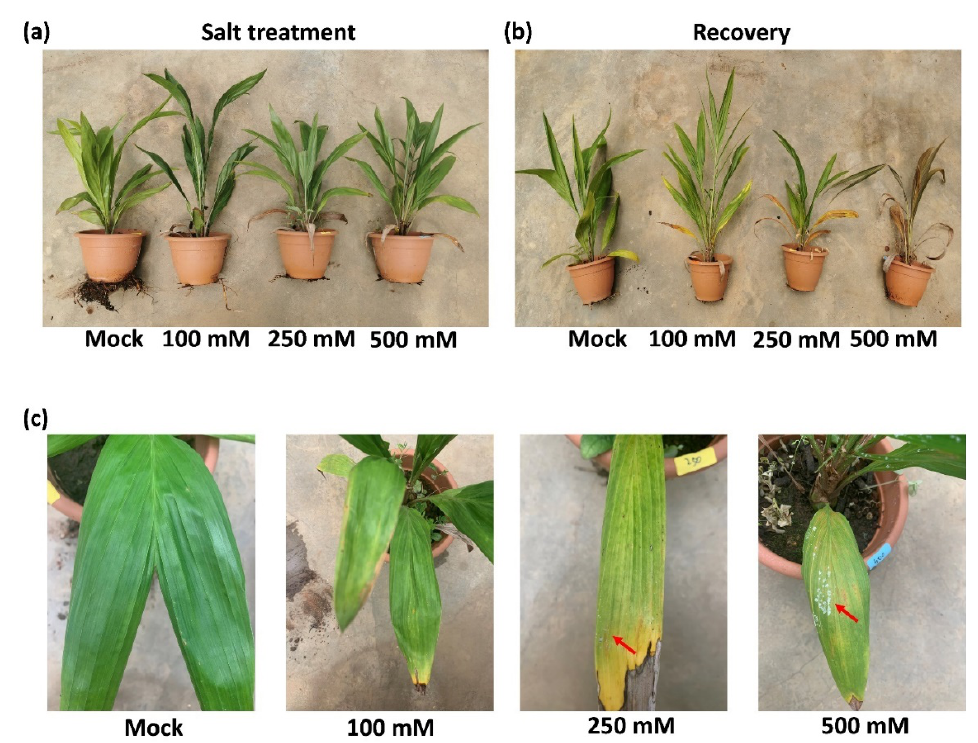
Figure 1. Phenotypical changes of oil palm seedlings in response to different levels of salt stress. ( a ) Circa 2-year-old oil palm seedlings were treated daily with either 150 mL water (Mock) or 150 mL NaCl with four gradient concentration: 100 mM, 250 mM, and 500 mM for 14 days. Four seedlings were used in each group as biological repeats. ( b ) All the seedlings from ( a ) were recovered with 150 mL water daily for another 14 days. ( c ) The leaves of oil palms from ( a ). Red arrows indicate the salt crystals emitted from leaf surface.